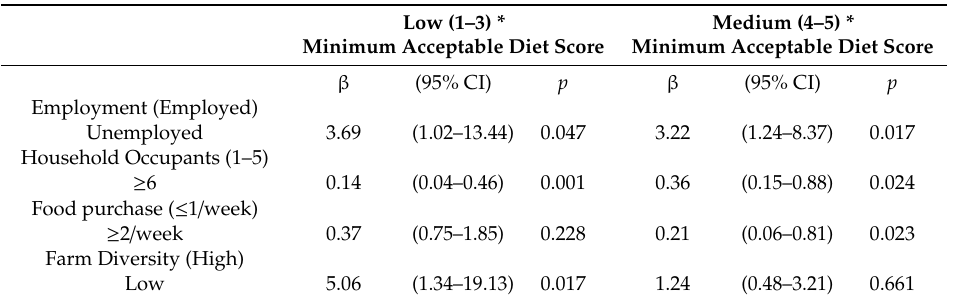
Table 5. Predictors of dietary diversity from adjusted multinomial logistic regression model ( n =